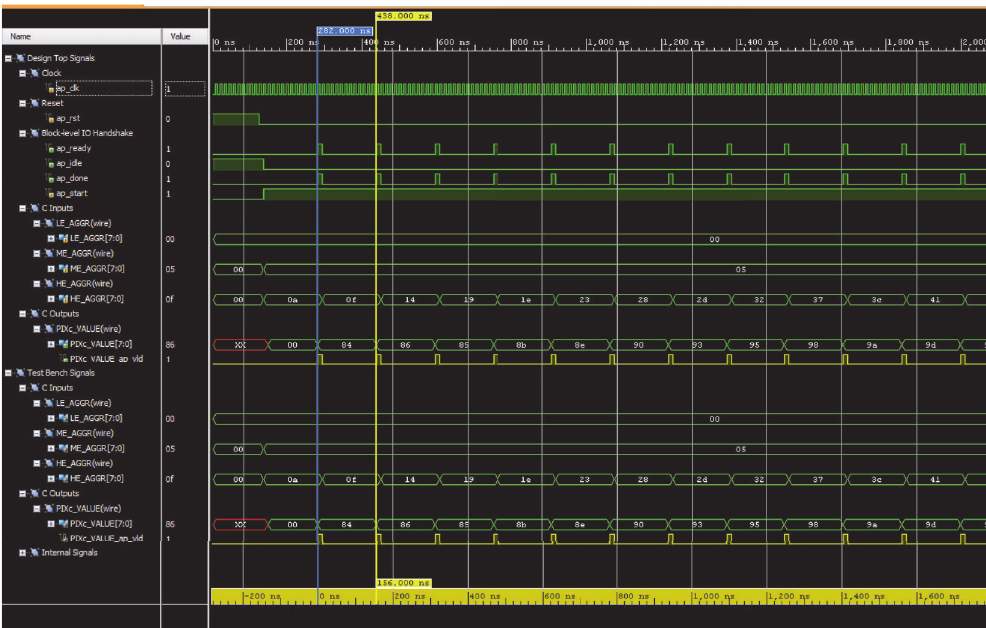
Figure 8: Simulation of the defuzzification unit using nonoptimized approach.